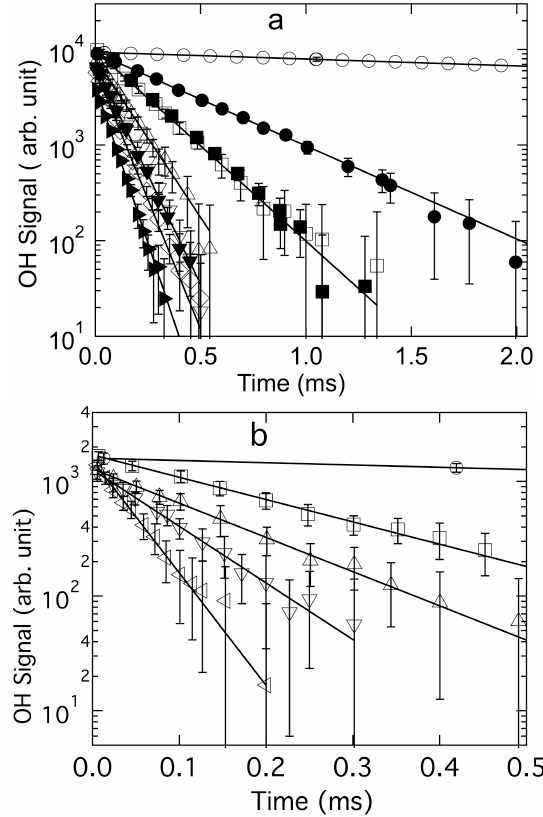
Fig. 2. Representative OH temporal profiles obtained at 295K us- ing H 2 O 2 photolysis at 248nm (upper panel) and at 211K using tert-butyl hydroperoxide (lower panel) as the OH radical sources. [CH 3 COCHO] (10 14 moleculecm − 3 ) ; open symbols: [O 2 ] = 0.0; filled symbols: [O 2 ] = 5.4 × 10 16 moleculecm − 3 ; upper panel: 0.0 • ( (cid:13) ), 1.64 ( ), 3.32 ( (cid:4) , (cid:3) ), 5.81 ( 4 ), 7.91 ( O , H ), 9.25 ( ♦ ), 11.54 ( I ); lower panel: 0.0 ( (cid:13) ), 1.23 ( (cid:3) ), 2.15 ( 4 ), 3.66 ( O ), 7.78 ( G ). Lines in (a) and (b) are fits of the data to Eq. (1). The OH profiles shown in the upper panel have been offset for clarity.